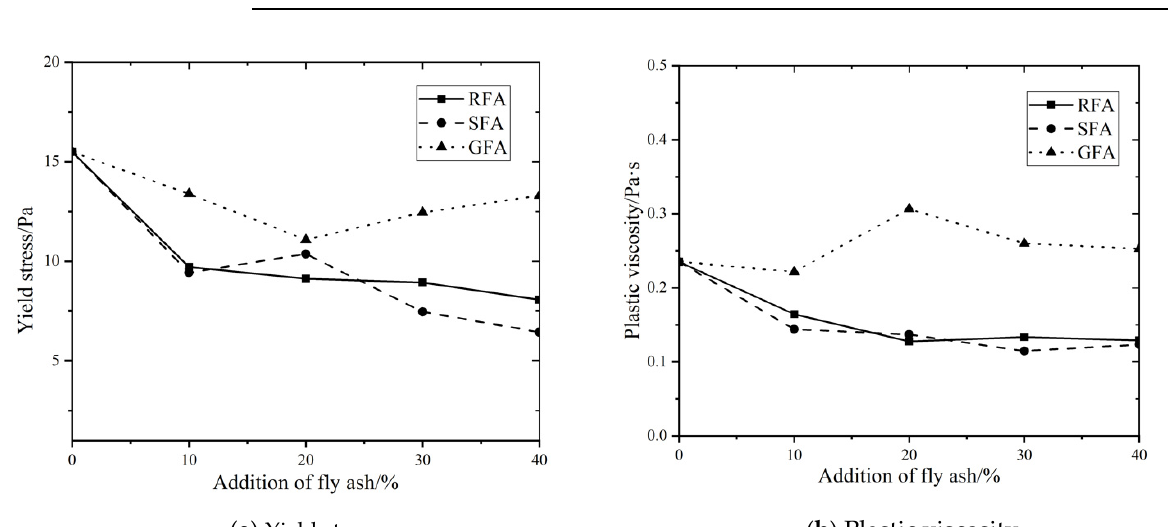
Figure 7. Rheological parameters of cement paste containing different fly ash.